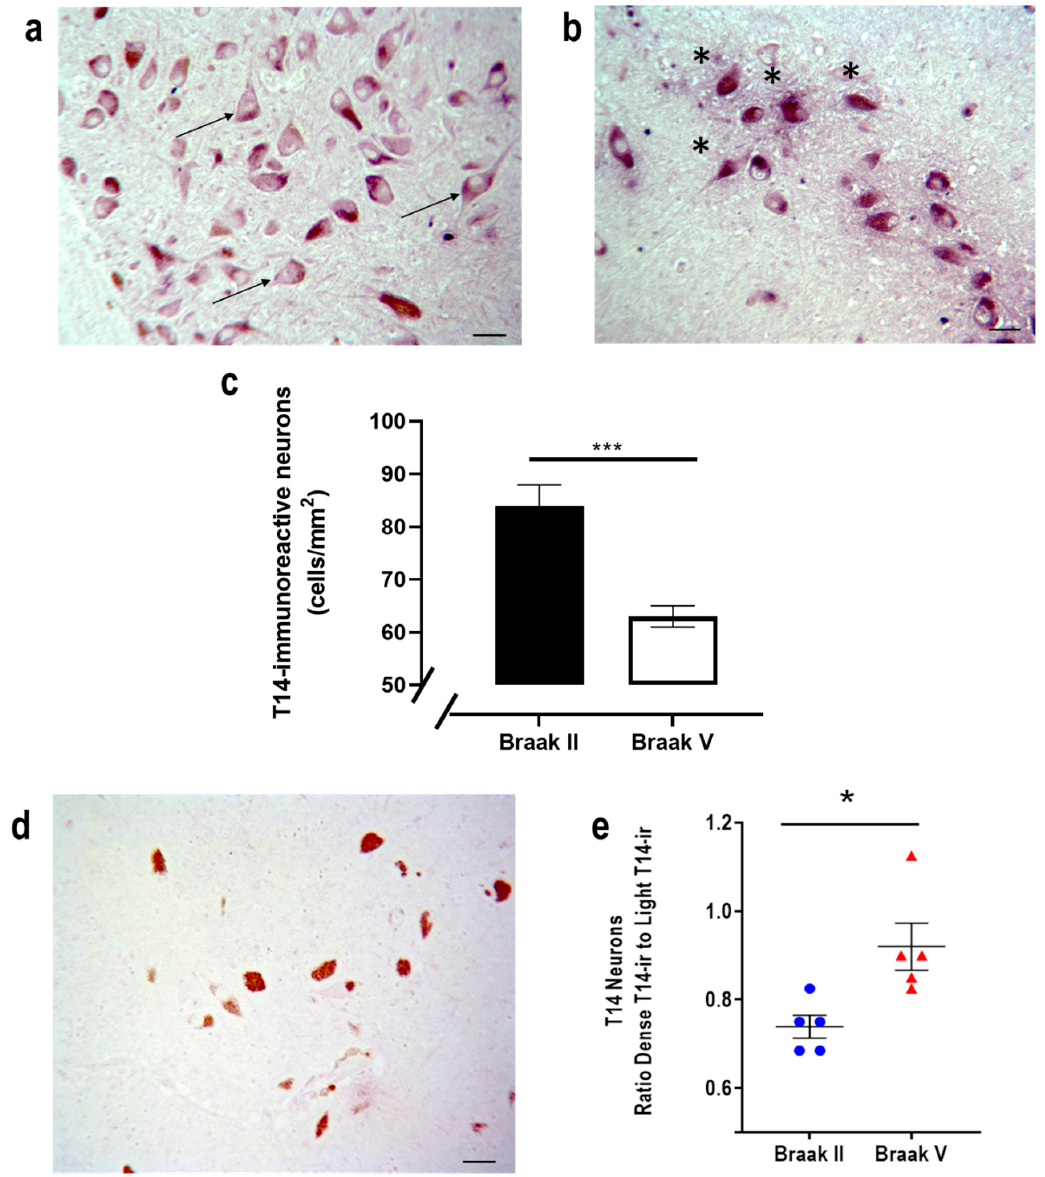
Figure 2. ( a , b , d ) Representative photomicrographs of human substantia nigra with T14 immunore- activity (scale bars: 50 µm). T14 immunoreactivity at ( a ) Braak II (arrows: examples of lightly im- munoreactive neurons) and ( b ) Braak V (asterisks: examples of densely immunoreactive neurons). ( c ) Quantification of cells in Braak II and V (n = 5 subjects in each group, *** p = 0.001, unpaired t - test). ( d ) Absence of T14 immunoreactivity following immunoneutralization of the primary anti- body with T14; the neuromelanin is now visible. ( e ) Ratio of dense T14-immunoreactive to light T14- immunoreactive neurons in the substantia nigra at Braak II and Braak V (n = 5 subjects in each group, * p < 0.05, unpaired t